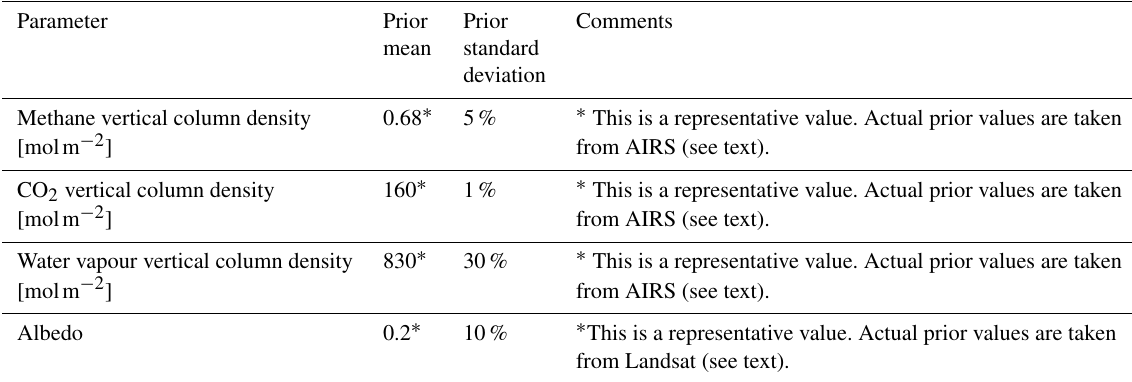
Table 3. Scene-wide average atmospheric state vector